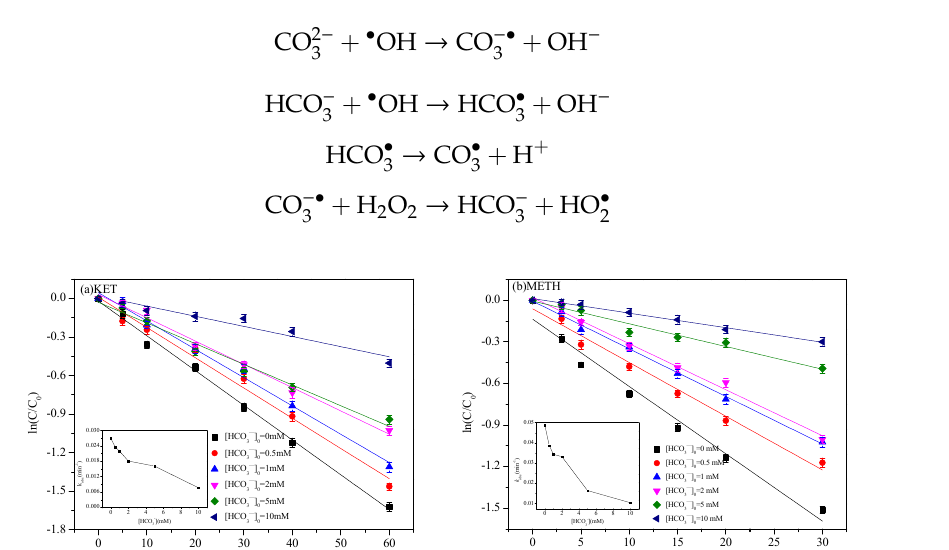
Figure 6. Effects of different initial pHs on the degradation of KET ( a ) and METH ( b ) in the UV/H 2 O 2 system. Conditions: (KET) 0 = (METH) 0 = 100 μg/L, (H 2 O 2 ) 0 = 500 μM, pH 0 = 3–11, T = 25 ± 1 °C.